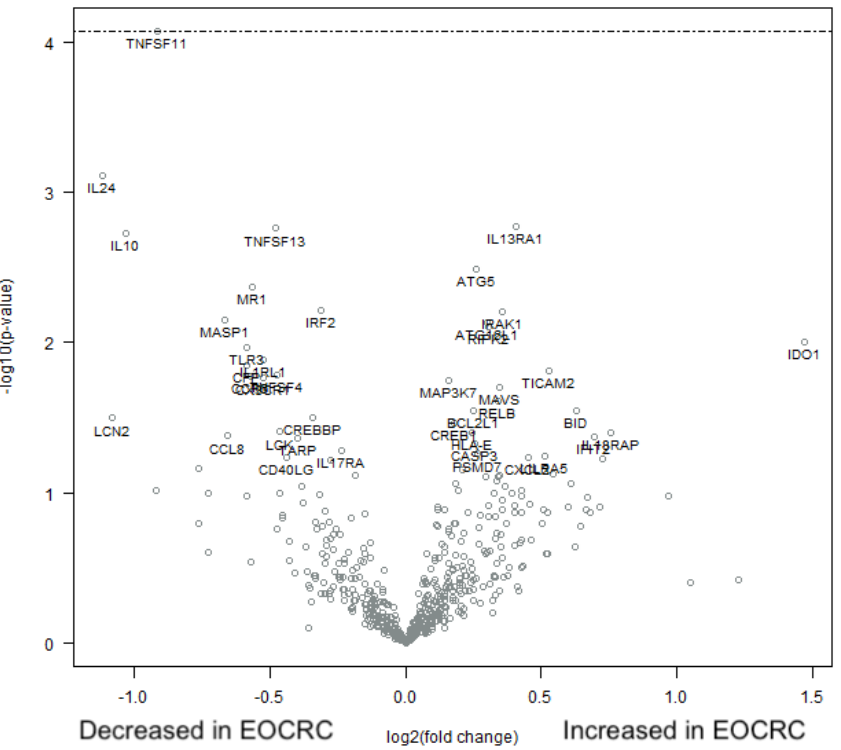
Figure 6. Immune profile in early and average-onset CRC tumors. RNA was extracted from formalin-fixed tumor tissue sections and analyzed using nCounter PanCancer Immune Profiling Panel. A volcano plot illustrating the relative up- and down-regulation of 770 genes in EOCRC tumors with AOCRC tumors as the baseline n = 20 in each group, respectively. The dashed line for the TNSF11 gene indicates p = 0.32 (32% false discoveries) in adjustment taking biologic gene-gene interactions into account.